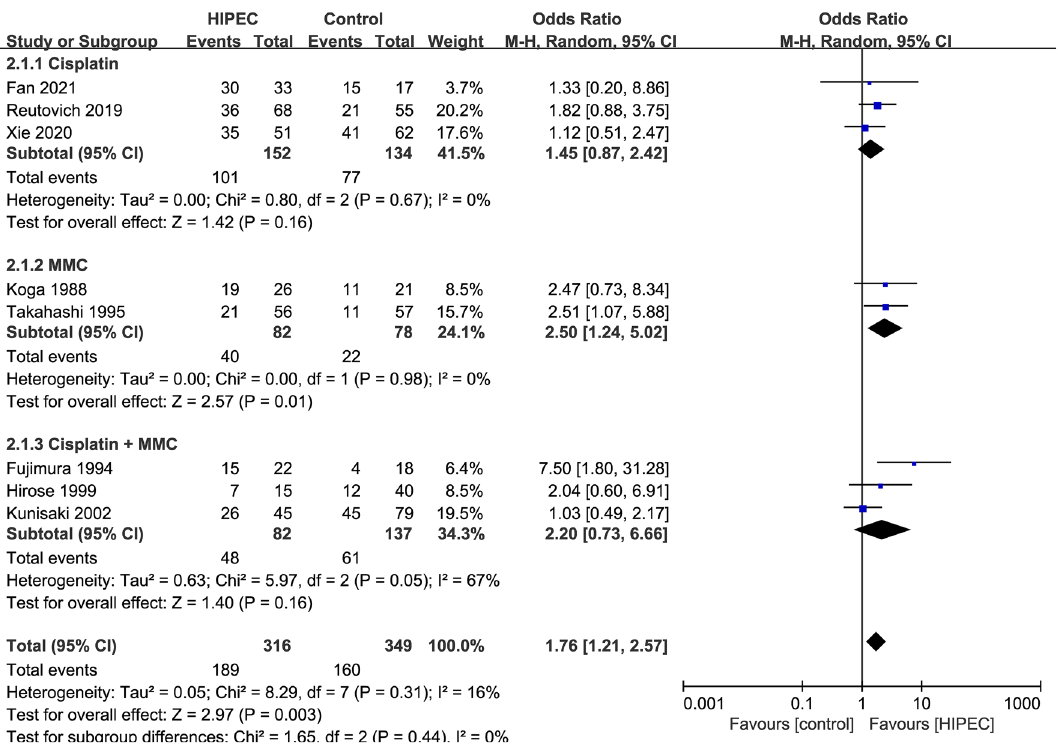
Figure 6. Overall 3-year survival in different HIPEC